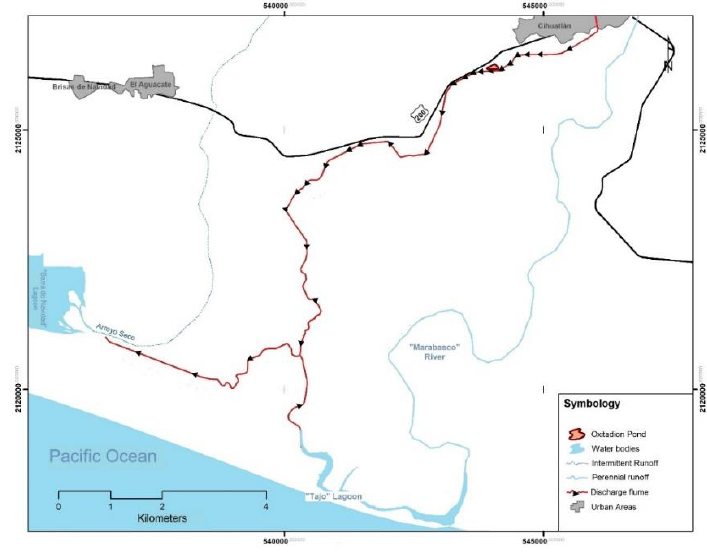
Figure 3. Location of “D” effluent.